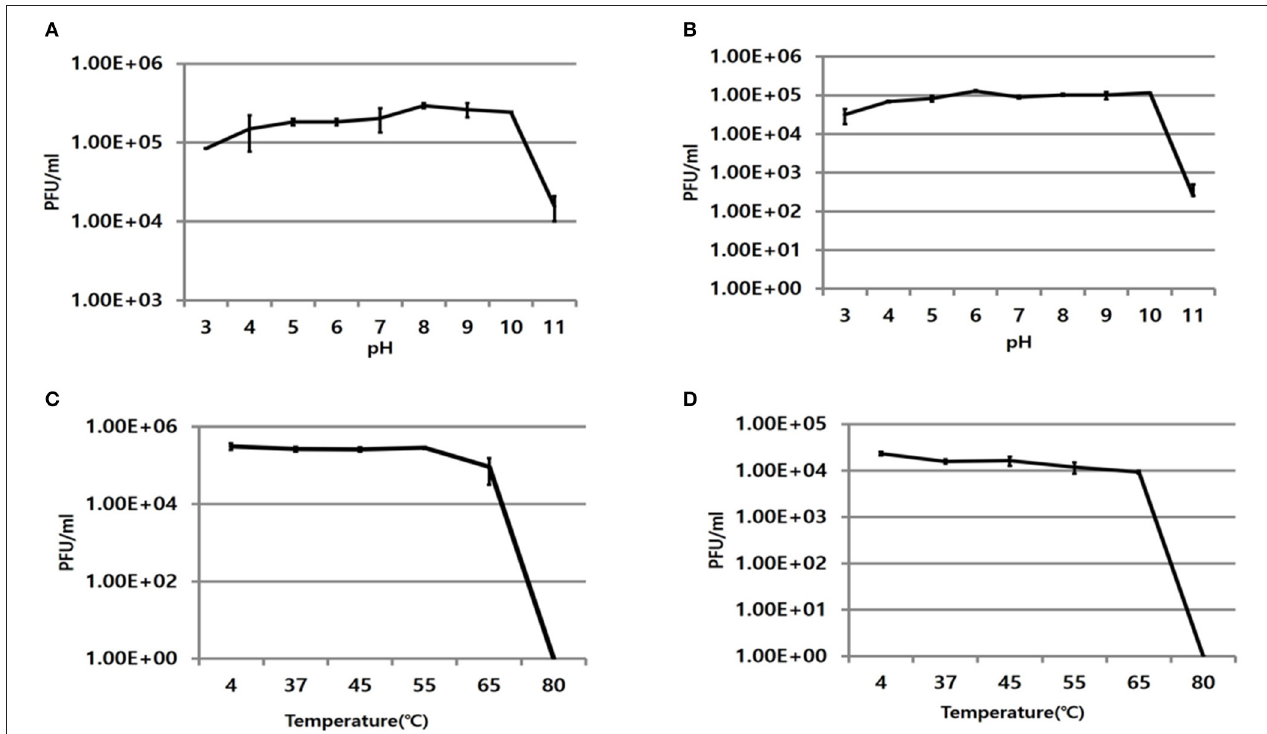
FIGURE 2 | Stability of phages at various pHs and temperatures. Remaining infectivity of phages PBAB08 (A) and PBAB25 (B) were measured after exposure of phages to indicated pHs for 1h. Remaining infectivity of phages PBAB08 (C) and PBAB25 (D) were measured after exposure of phages to indicated temperatures for 1h. The experiments were carried out in a triplicate.